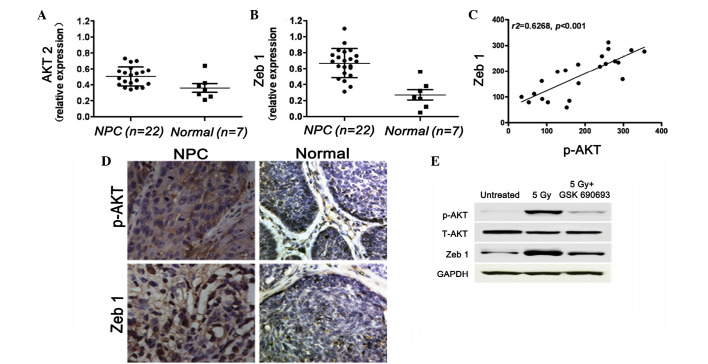
Expression of (A) AKT and (B) ZEB1 mRNA in 22 NPC patient and 7 normal samples. (C) Scatterplot demonstrating the correlation between ZEB1 and AKT. (D) IHC for pAKT, AKT and ZEB1 expression in human NPC patient and normal samples (E) Western blot analysis for total protein extracts of pAKT, AKT and ZEB1 from NPC cells treated with 5 Gy IR and cotreated with IR and GSK690693. GAPDH was used to determine equal protein loading. Normal, chronic inflammation of nasopharynx or tissues adjacent to NPC; NPC, nasopharyngeal carcinoma; IHC, immunohistochemistry; IR, ionizing radiation.